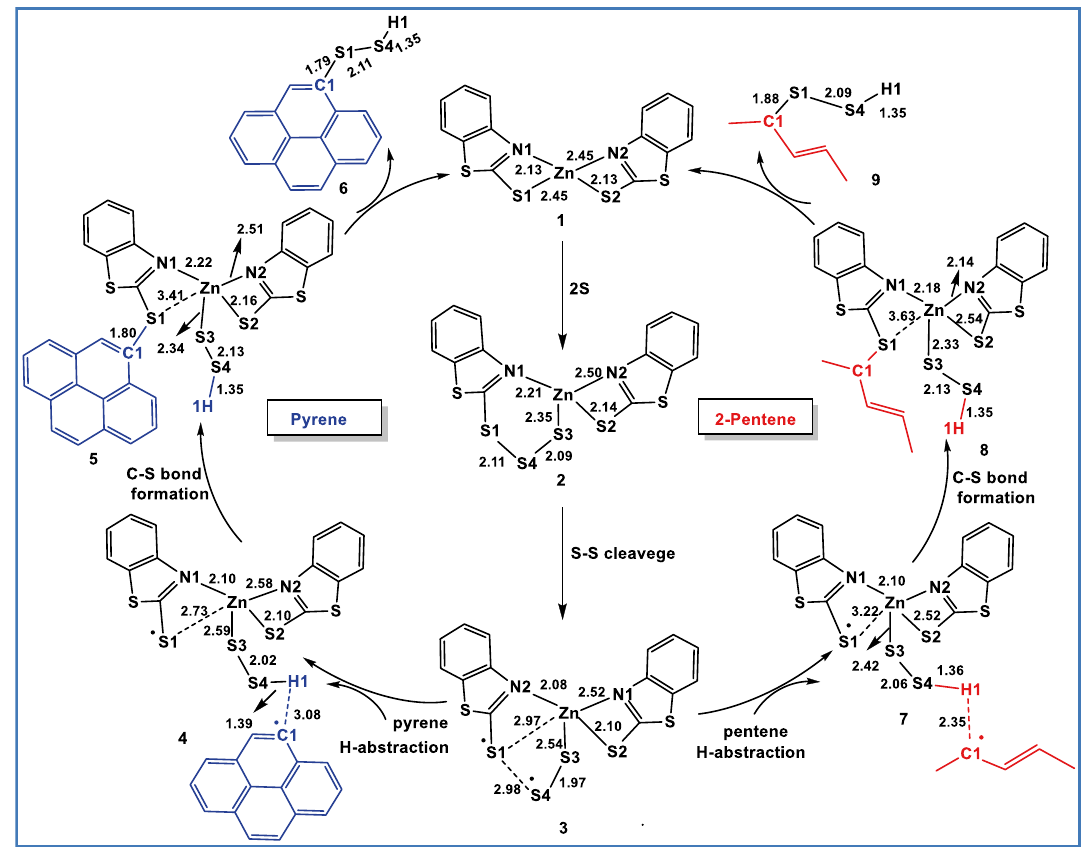
Figure 7. Modelled mechanism for ZMBT assisted sulfuration of pyrene and 2-pentene. Optimized bond lengths are shown in